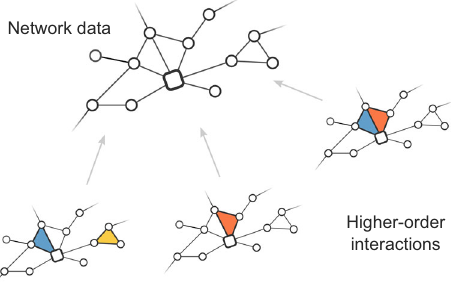
Fig. 1 Projected higher-order interactions. We show the extended ego network (circle nodes) of a participant (square node) of the AddHealth study 14 . Friendships are measured between pairs of participants (links and nodes, respectively), even when the fundamental units are groups of friends 12 . Multiple combinations of groups and isolated friendships lead to the same network (gray